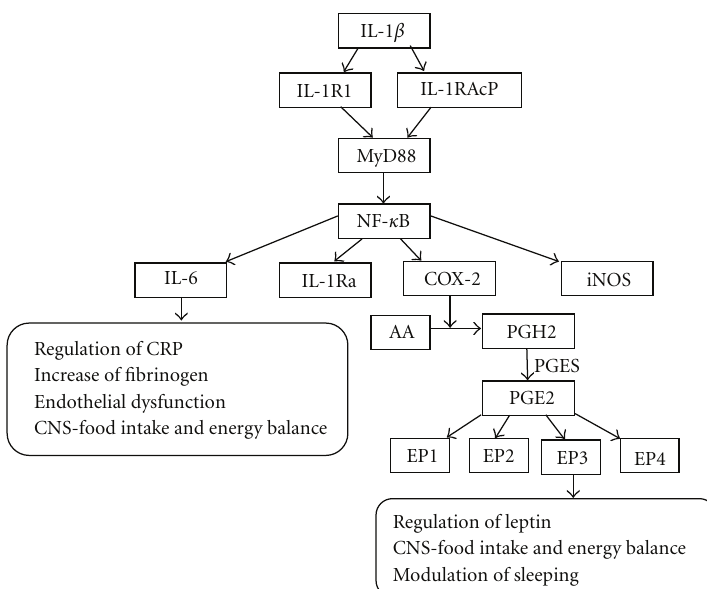
Figure 3: Interleukin-1 β (IL-1 β ) induction of interleukin-6 (IL-6) and prostaglandin E2 (PGE2) signaling. IL-1 β binds to the IL-1R1/IL- 1R1AcP heterodimer, which then initiates the signaling cascade that causes the translocation of the transcription factor nuclear factor- κ B (NF- κ B) into the nucleus, where it induces the transcription of pro- and anti-inflammatory genes including inducible nitric oxide synthetase (iNOS), IL-6, IL-1Ra and cyclooxygenase-2 (COX-2). COX-2 catalyses the conversion of arachidonic acid (AA) to prostaglandin H2 (PGH2). PGH2 is converted into PGE2 by terminal PGE synthase (PGES). PGE2 signals occur via four di ff erent G-protein coupled receptors, EP1R- EP4R, each of which has multiple splice variants with di ff erent signaling